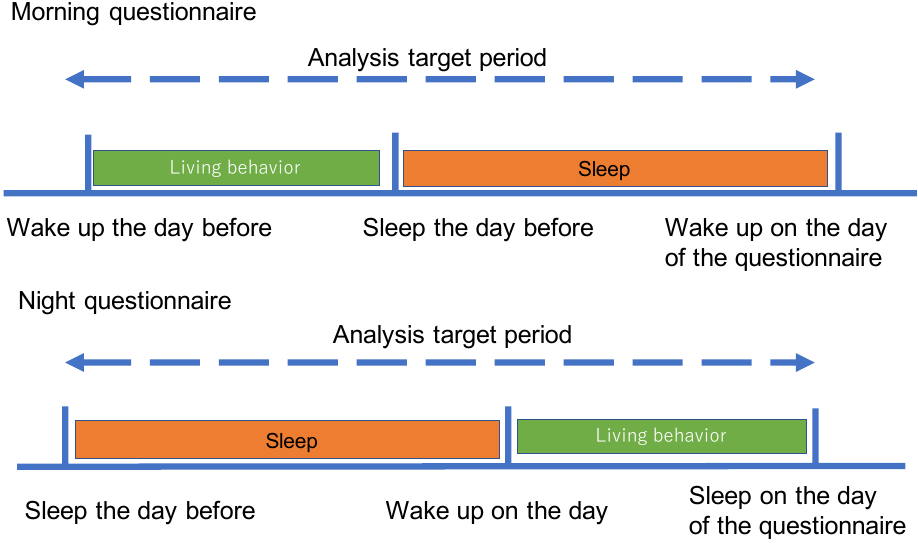
Figure 5. Aggregation period for morning and night